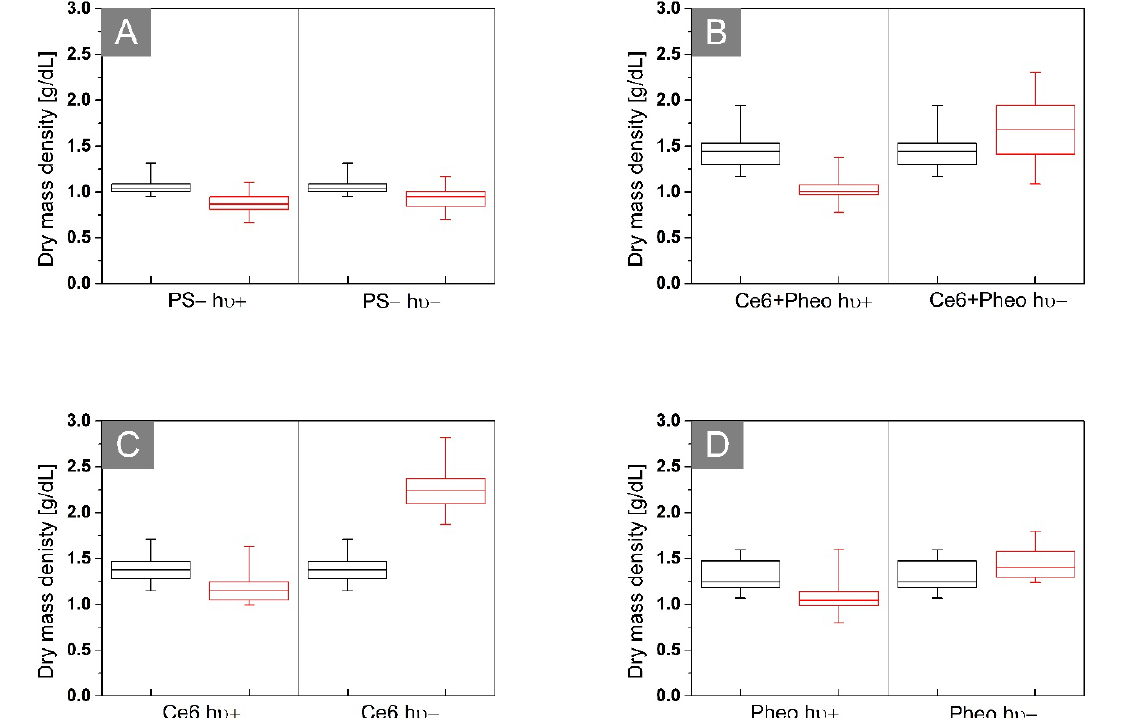
Figure 11. Representative box plots of dry mass density of biofilms of E. coli after incubation ( A ) without PS or with ( B ) Ce6 + Pheo, ( C ) Ce6, ( D ) Pheo, h ν +: irradiated, hν− : not irradiated. The black boxes represent the distribution of RI values after 24 h, and the red boxes 48 h after the start of the experiment. Table 3. The averaged dry mass density with standard deviation before and after irradiation for all analyzed